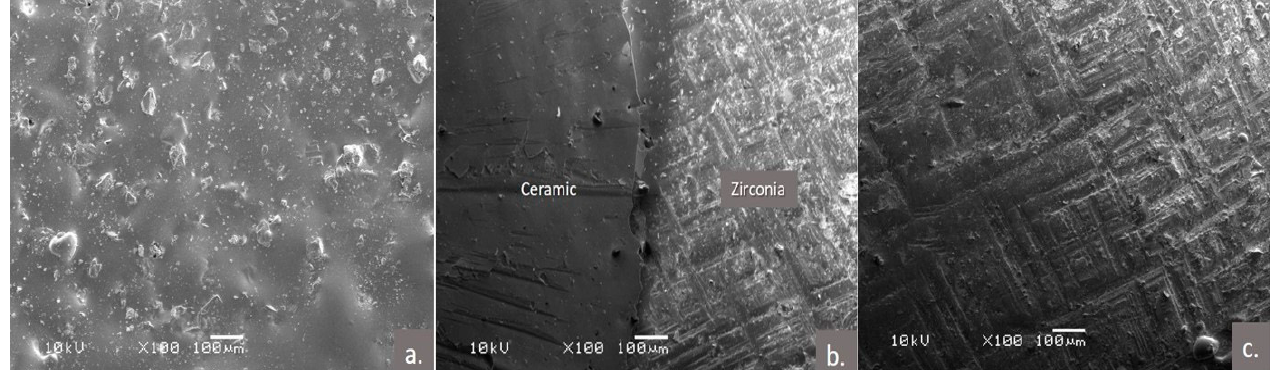
Figure 3. Representative scanning electron microscopic images (SEM) of; ( a ) ceramic surface; ( b ) ceramic zirconia interface; ( c ) zirconia surface after the ceramic chip off, small remnants of ceramic can be noted.